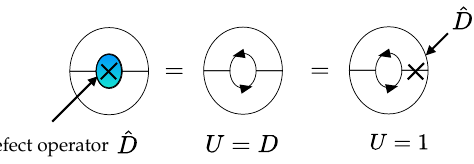
Figure 8 . On the left,the blue disk corresponds to a (0 , 0) cap with trivial bundle structure. To obtain the Calabi Yau cap, a defect operator is inserted to implement the nontrivial